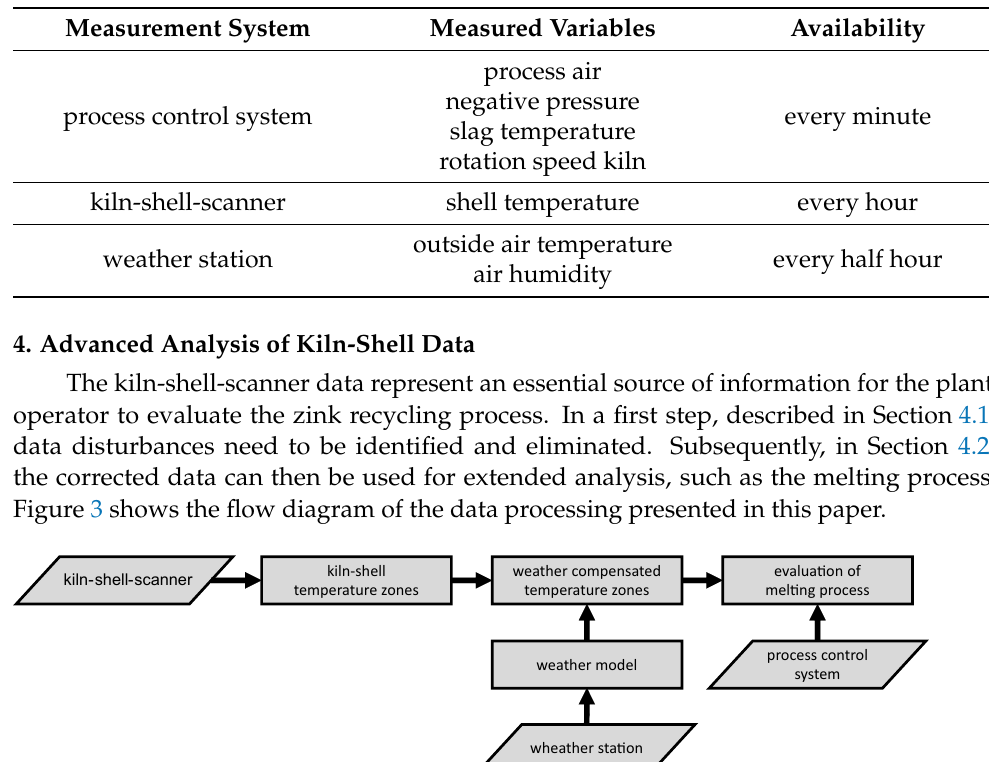
Table 1. Used data basis for analyzing zinc recycling processes.